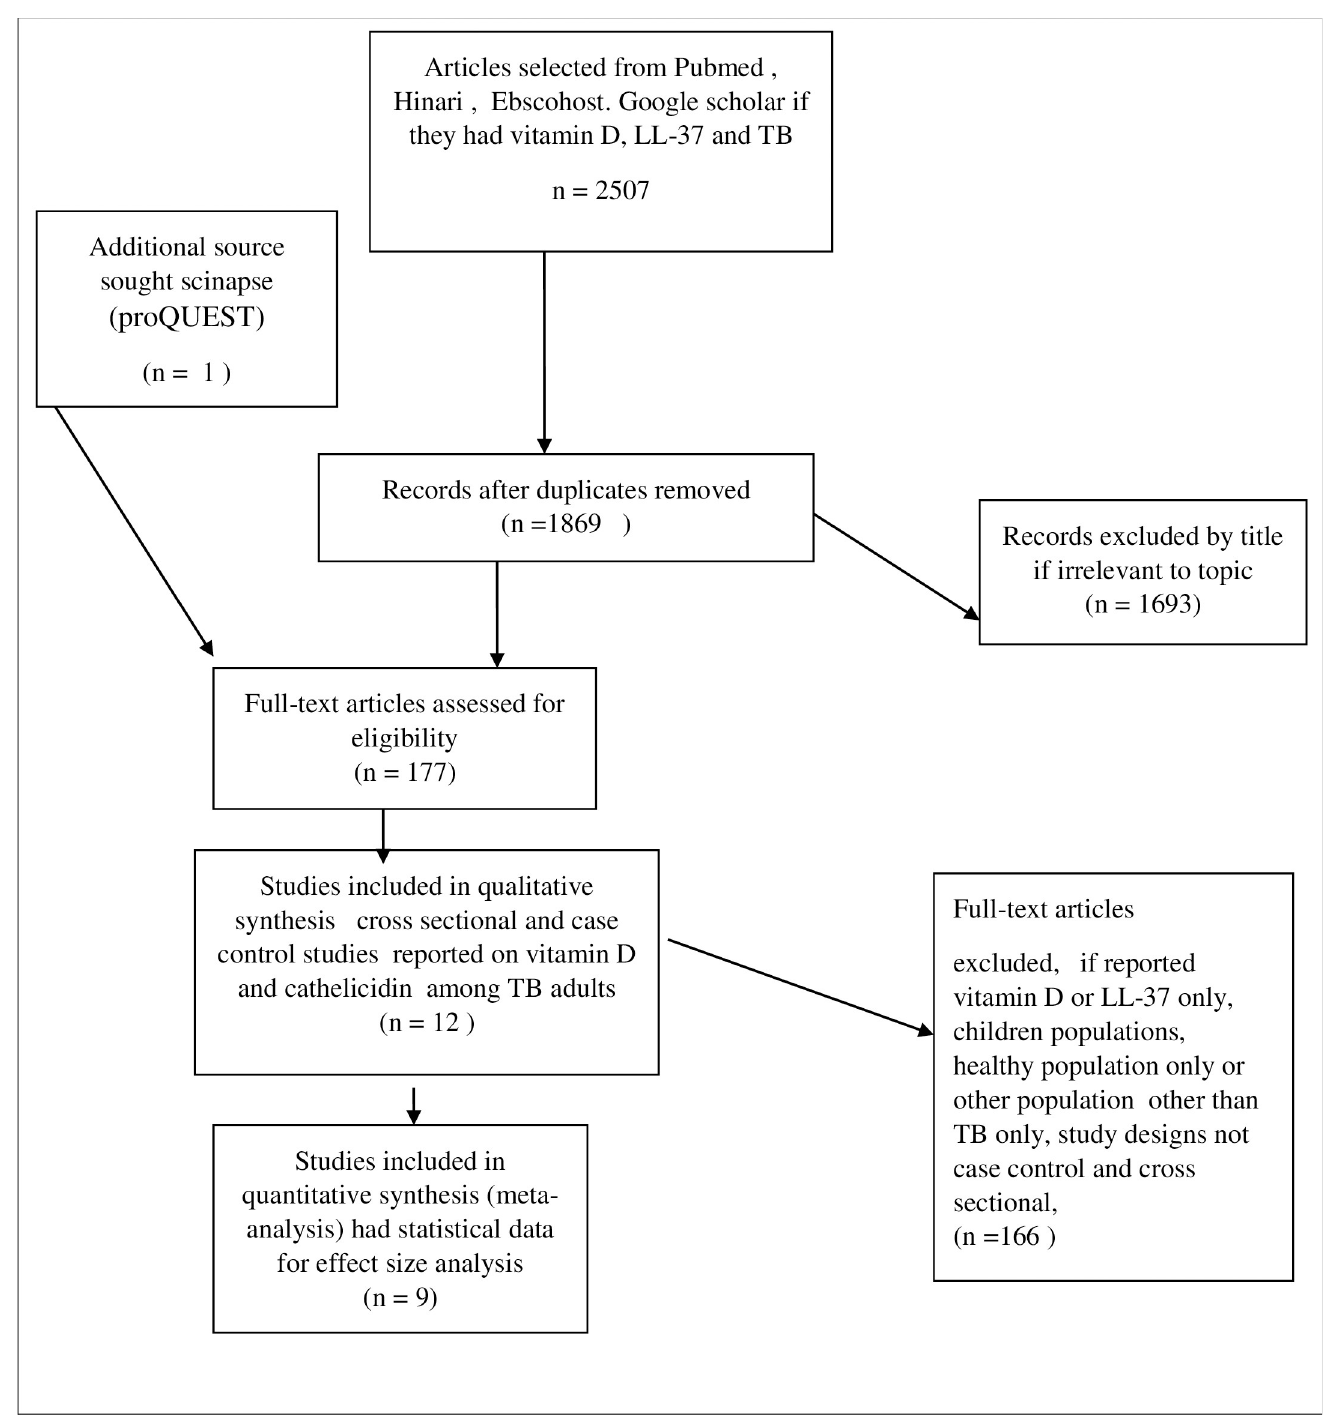
Fig 1. Flow diagram of review searching and selection